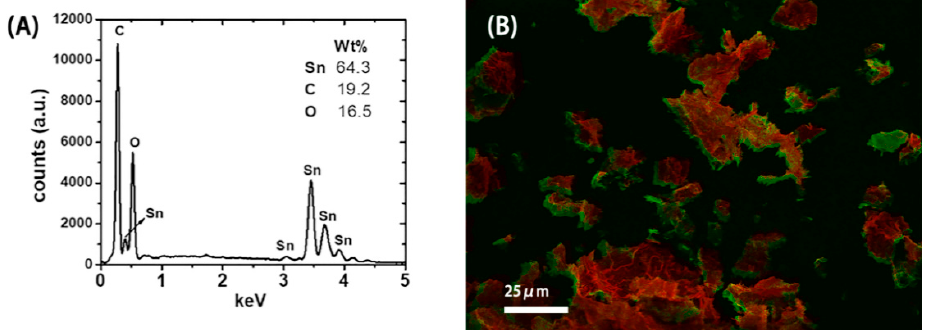
Figure 3. ( A ) Energy-dispersive X-ray (EDX) spectrum showing the main atomic composition of the SnO 2 -reduced graphene oxide (rGO) material. ( B ) SEM-EDX map showing the distribution of Sn (red) and C (green).